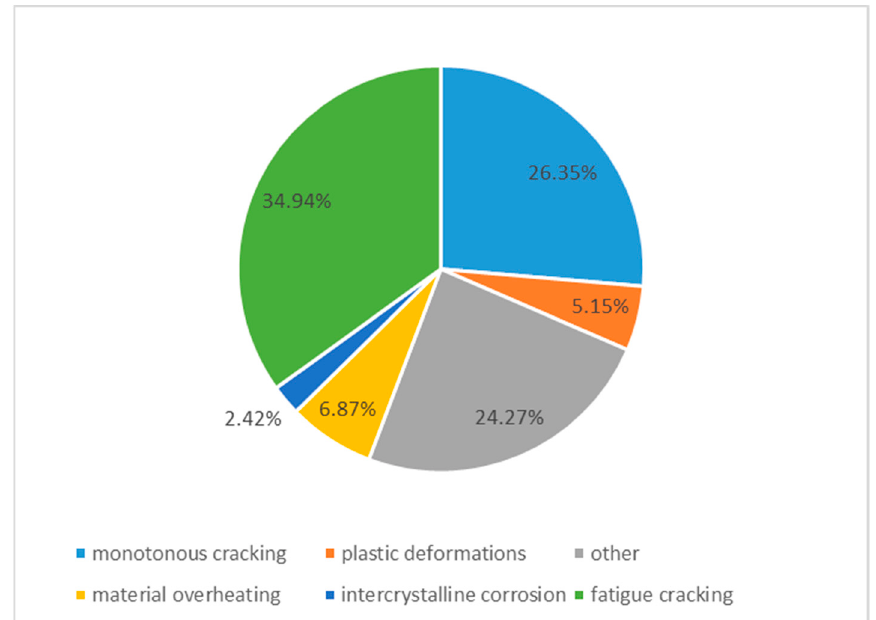
Figure 1. Causes behind aircraft turbine engine damages in the course of operation (Adapted with permission from Ref. [6]. 2007, AFIT.).